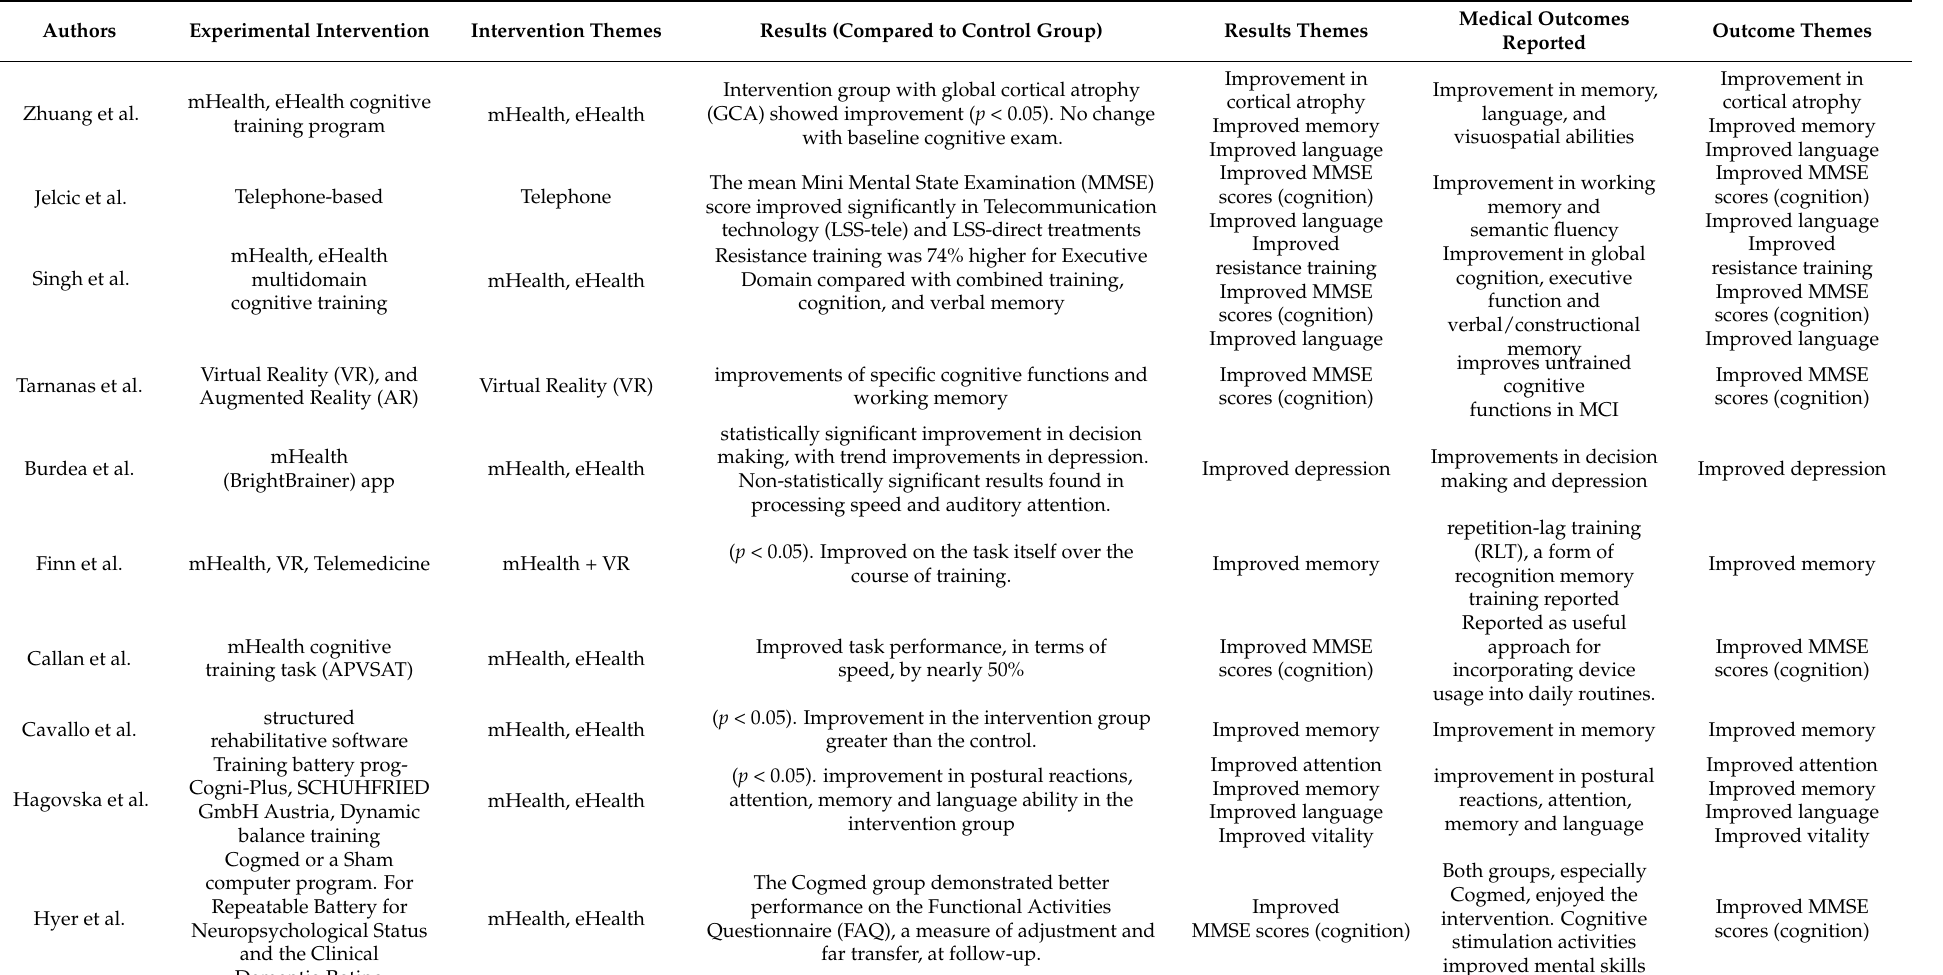
Table A1. Observation-to-theme conversion (Intervention, Results, and Medical